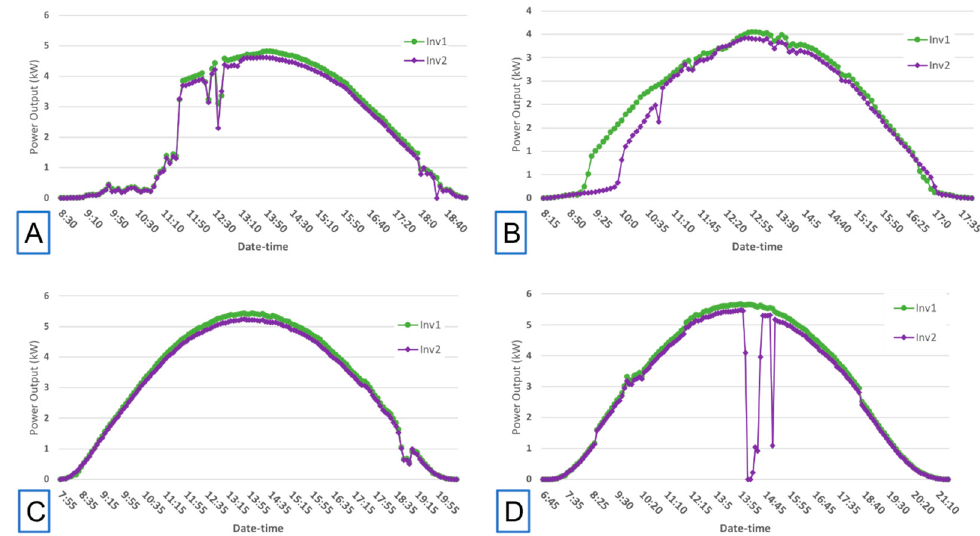
Figure 8. Power output of two groups of modules with same nominal power and same location. Four days are shown from different season: ( A ) October, ( B ) December, ( C ) April and ( D ) June.